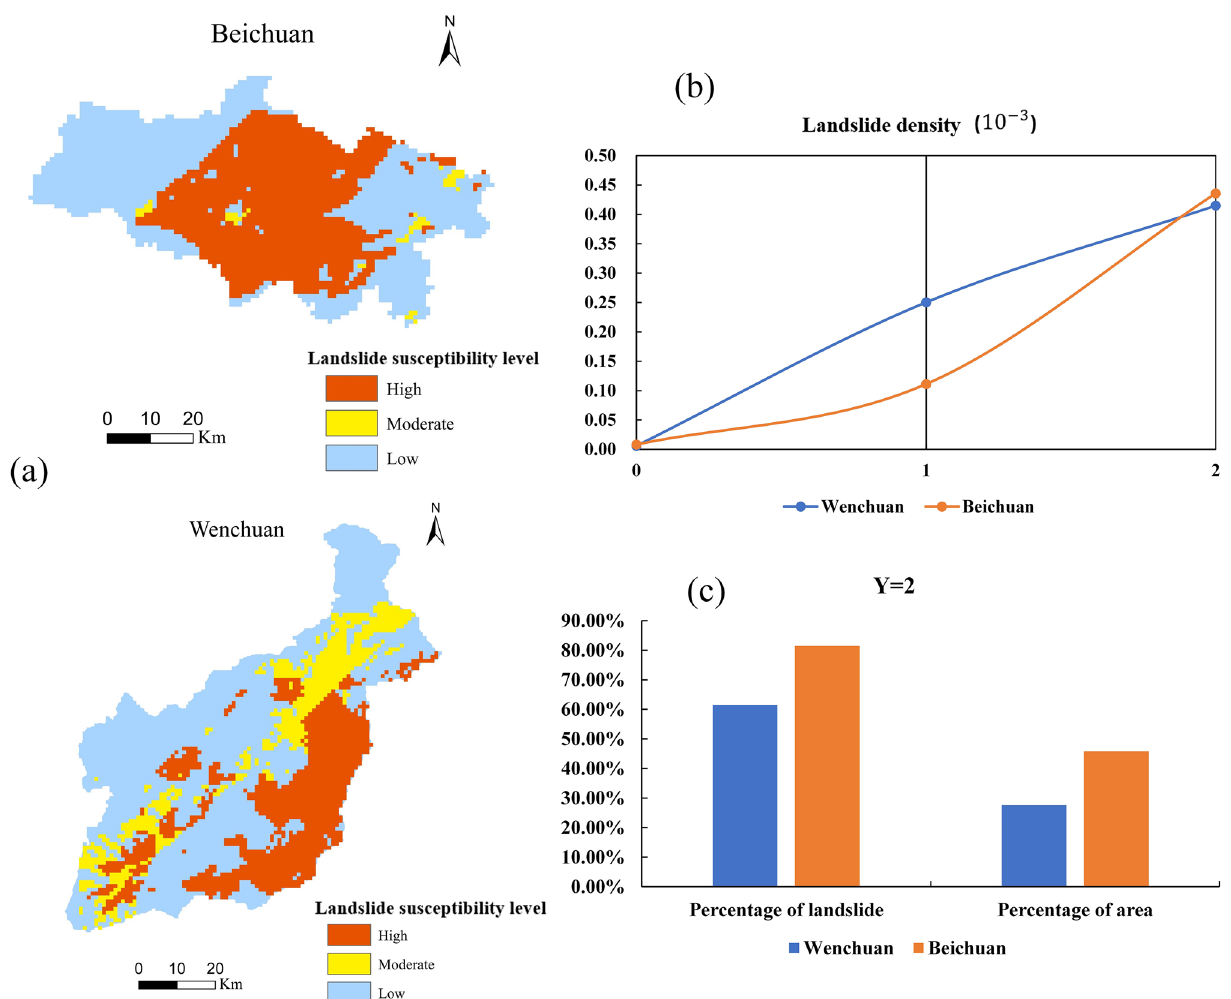
Figure 8. Map of Wenchuan and Beichuan with regional statistical results (Names of software: ArcGIS 10.5 and Office